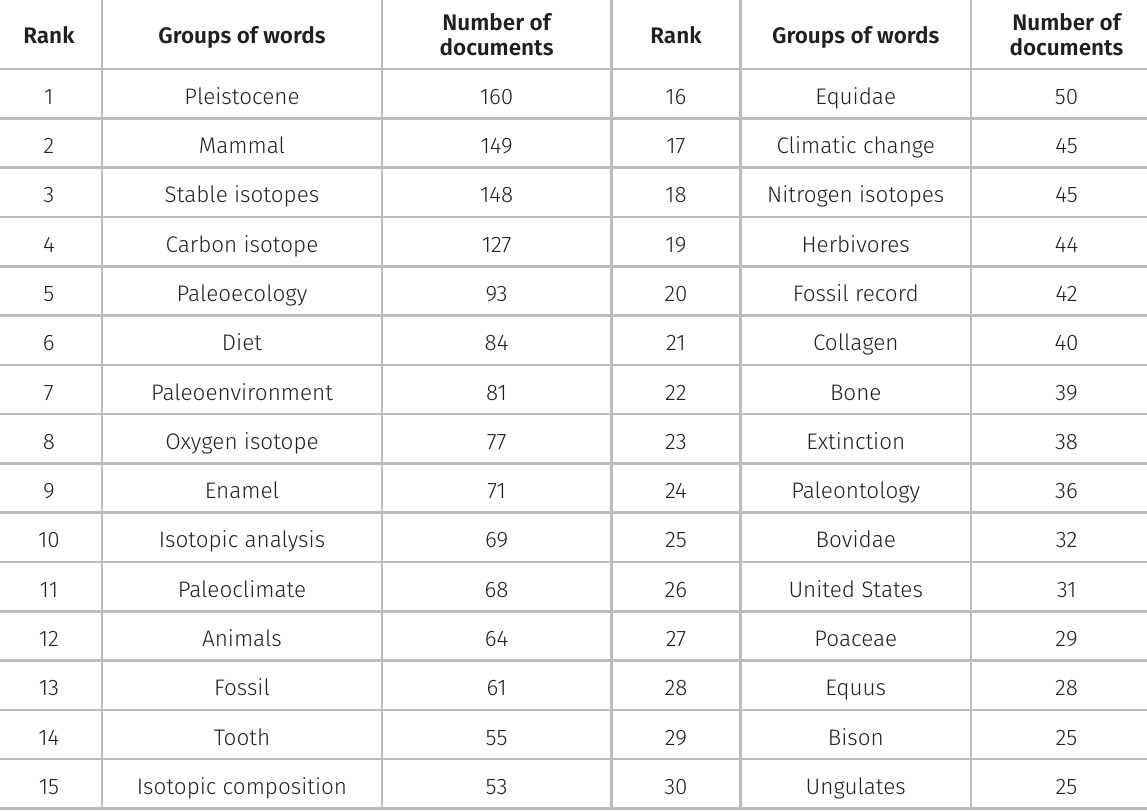
Table III. Top thirty most used keywords in isotopic studies on Quaternary megafauna fossils.